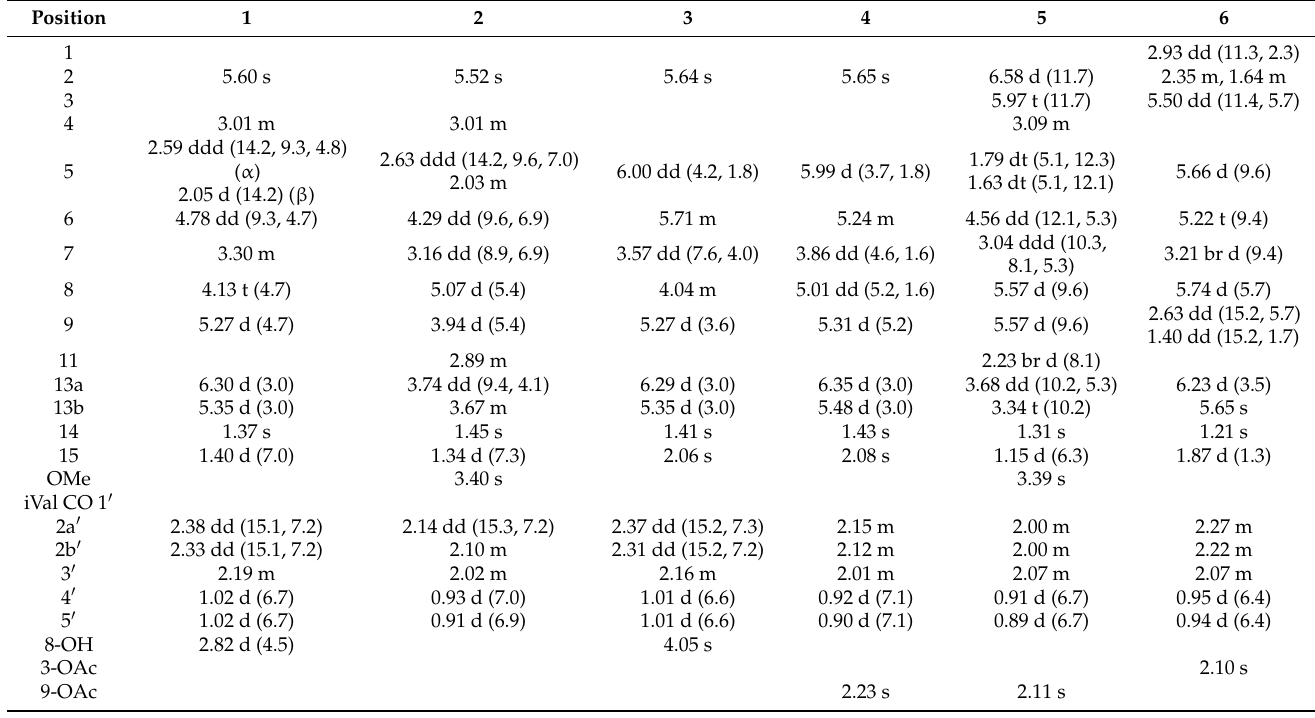
Table 1. 1 H NMR data of compounds 1 – 6 in CDCl 3 at 500 MHz ( δ in ppm, mult. J in